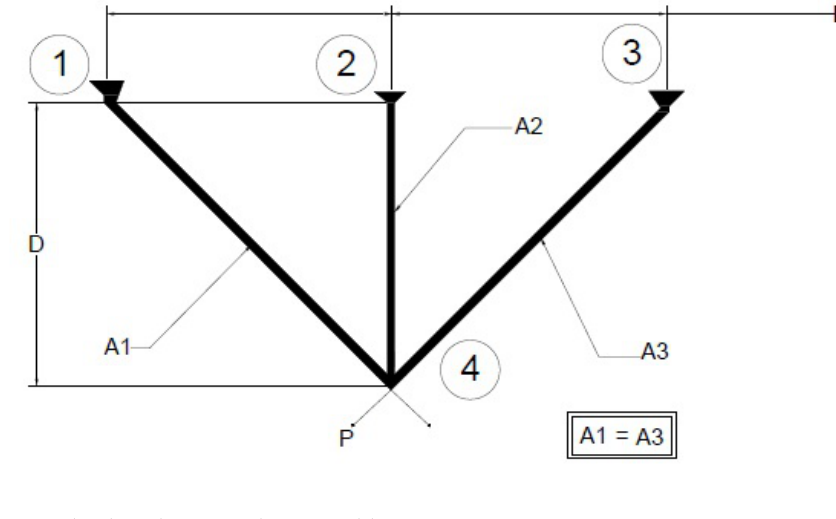
Figure 5. The three-bar truss design